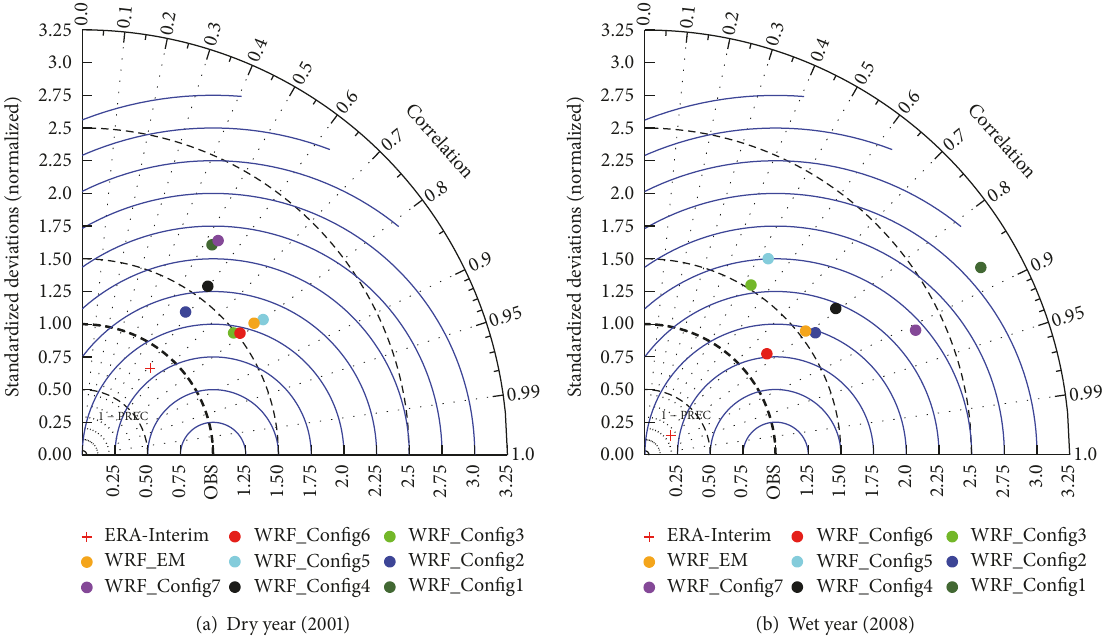
Figure 7: Taylor diagram showing the statistical summary for the transitional zone for the (a) dry year (2001) and (b) wet year (2008).